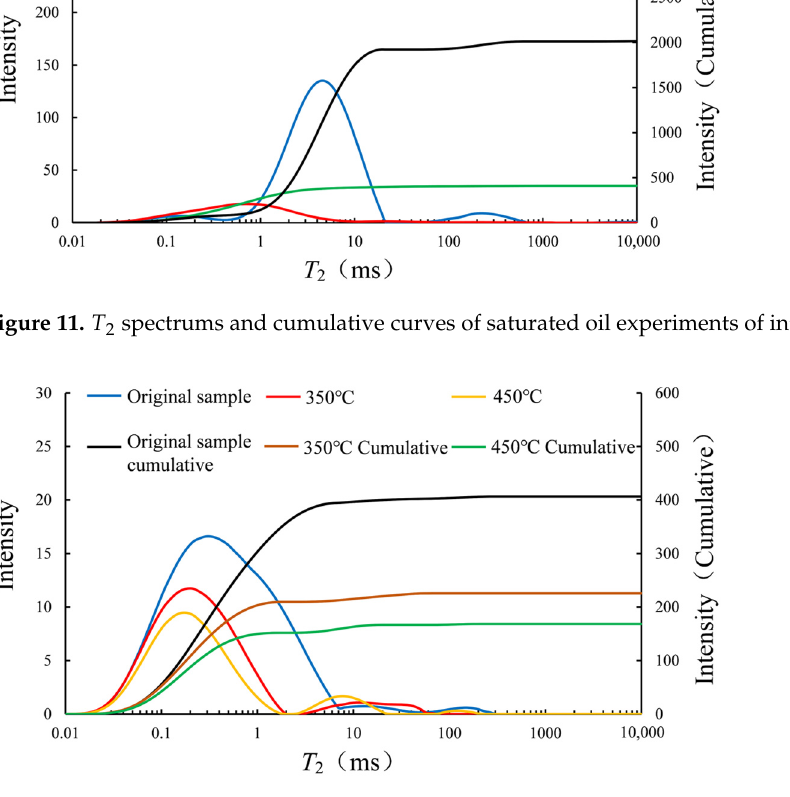
Figure 12. T 2 spectrums and cumulative curves of multi-temperature experiments of inter-salt